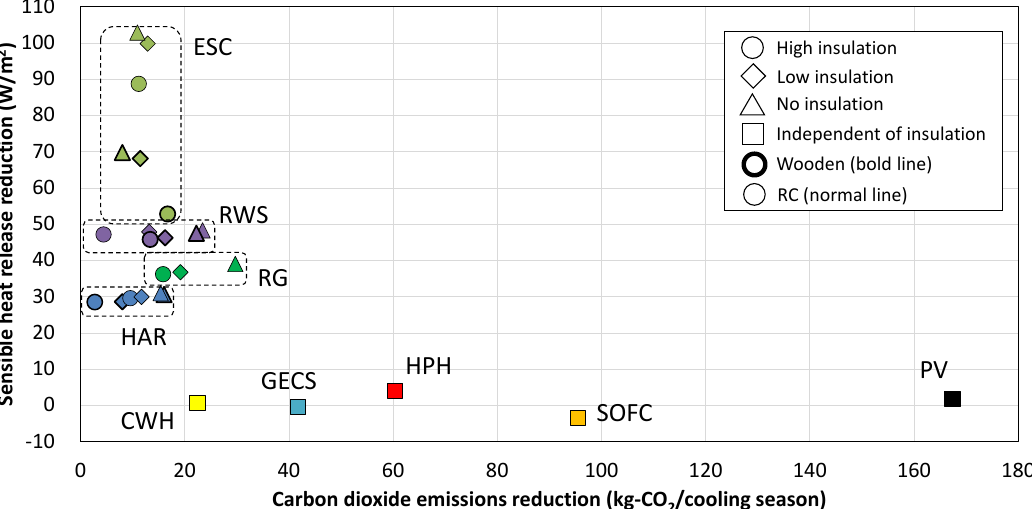
Figure 11. Diurnal (24-h) average reduction in sensible heat release on an average value of sunny days in August versus total summer (July–September) reduction in CO 2 emissions upon applying each countermeasure.